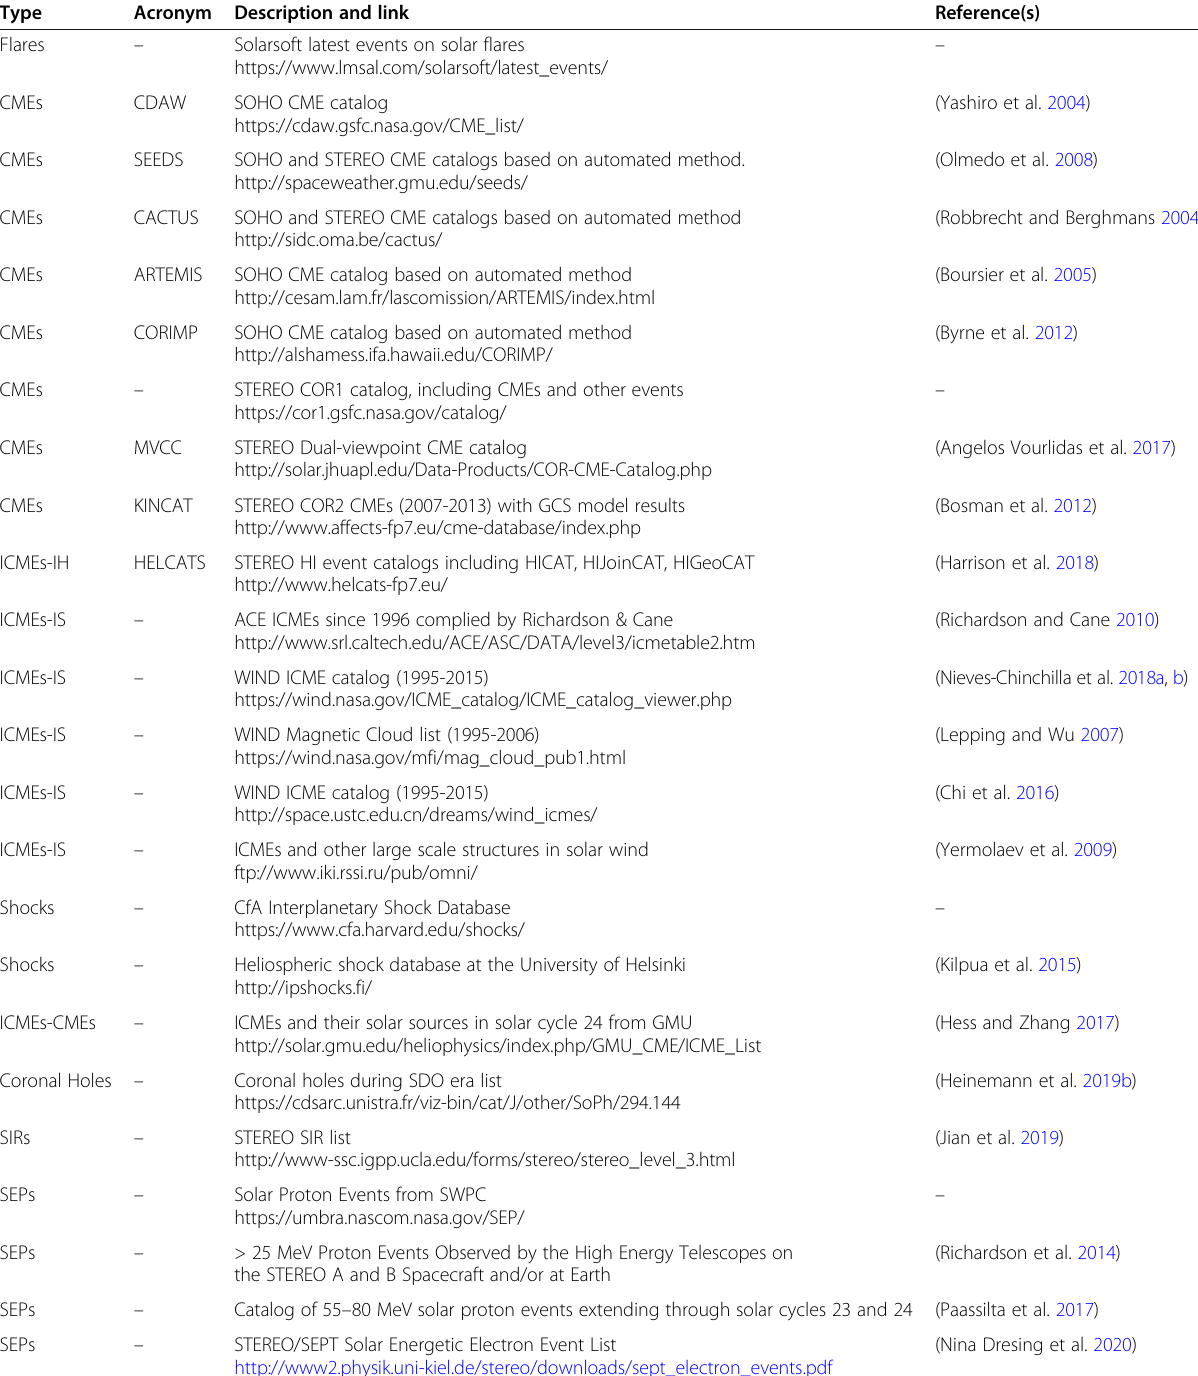
Table 3 Catalogs of Earth-affecting solar transients, including flares, CMEs, ICMEs-IH (inner heliosphere), ICMEs-IS (in situ), shocks, SIRs and